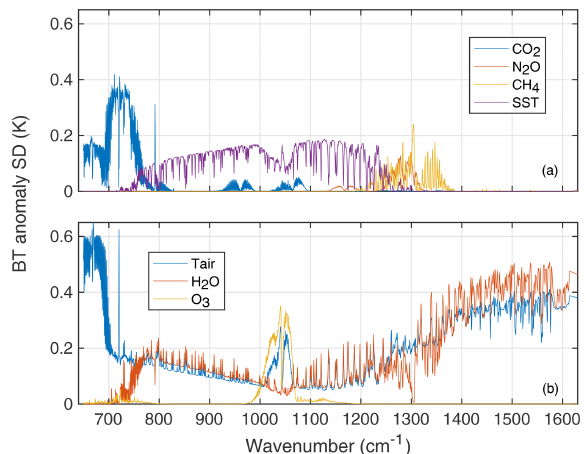
Figure 20. Standard deviation for the contribution to the observed BT anomalies caused by the mean retrieved geophysical anomalies shown in Fig.